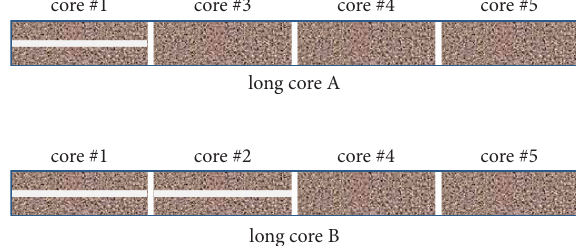
Figure 3: Schematic diagram of long core A and long core B.